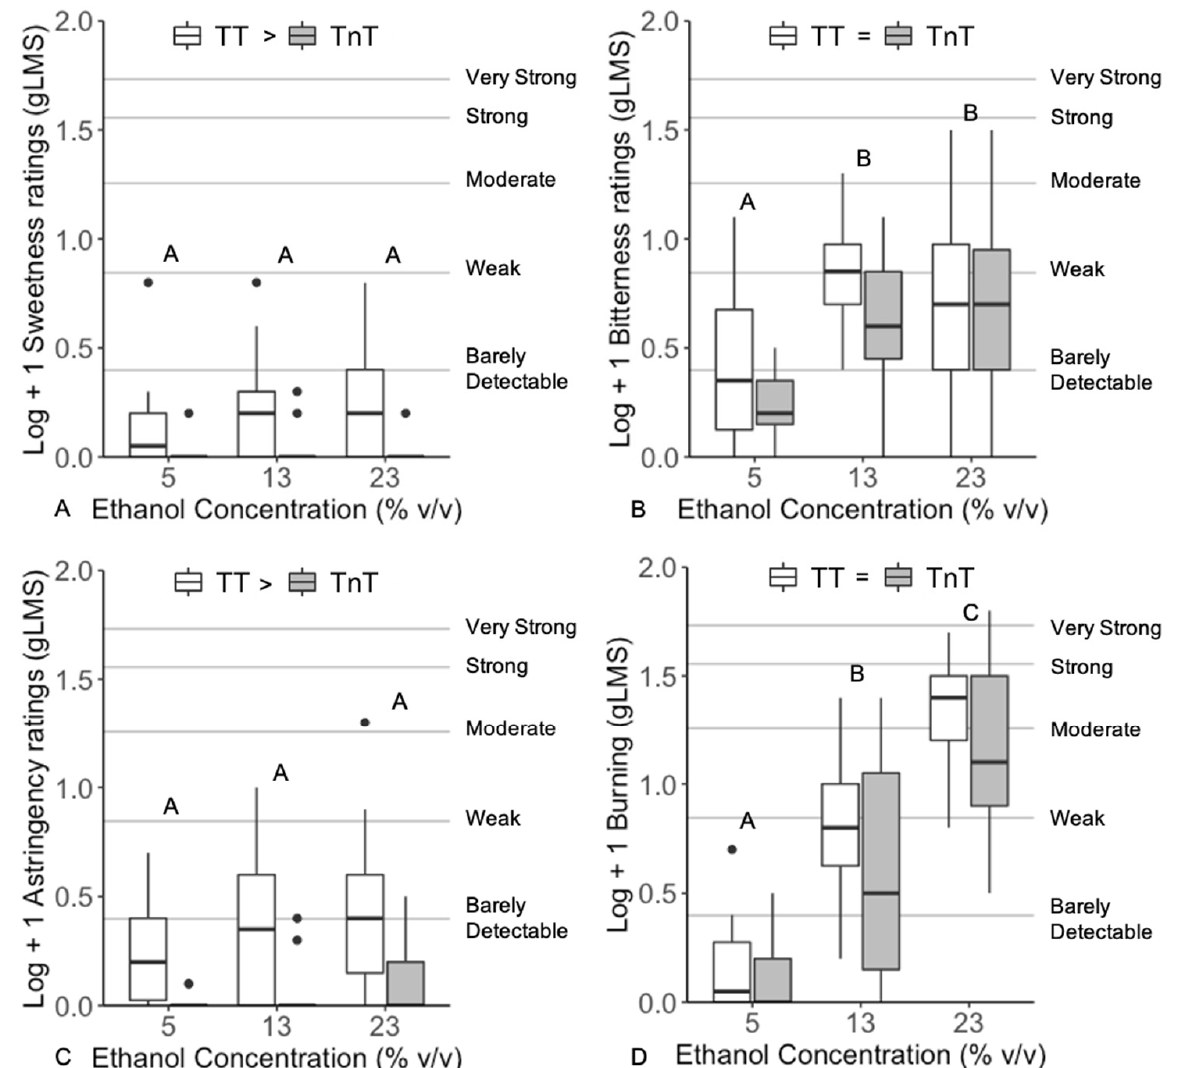
Figure 2. Boxplots of mean intensity elicited by unary solutions of ethanol by concentration (5, 13, 23% v/v ) and thermal taste status (18 TT, 11 TnT) for sweet ( A ), bitter ( B ), astringent ( C ) and burning/tingling ( D ). Significant differences between concentrations are shown with different letters above the boxplots. Significant differences between TT and TnT are indicated by the mathematical symbols in the legend.